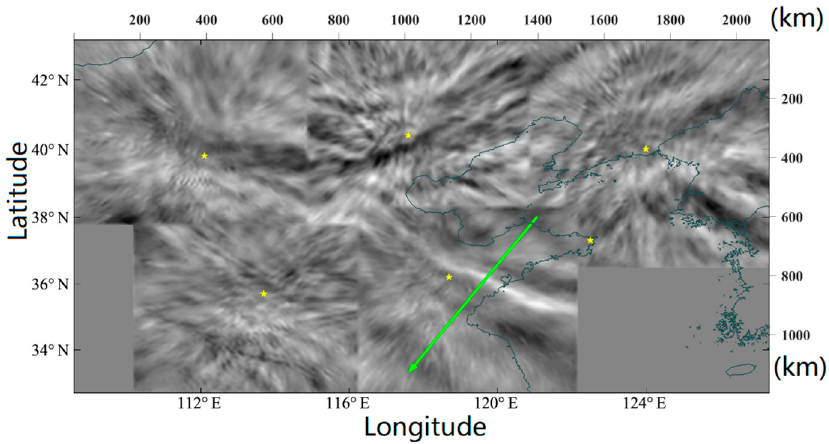
Figure 6. Assembled airglow image after denoising. The axes above and to the right represent the position. The lower and left axes indicate the longitude and latitude, respectively. The ASAI stations are marked with yellow points. This image is obtained by superposing all of the images in Figure 5, showing wave patterns with more visibility than Figure 1. The green arrow indicates the propagating direction of the local GWs, which is perpendicular to most wave surfaces it crosses. Table 2. Wavelength, horizontal speed, and relative fluctuation of quasi-monochromatic GWs with different scales. The values listed are the average and variance of multiple